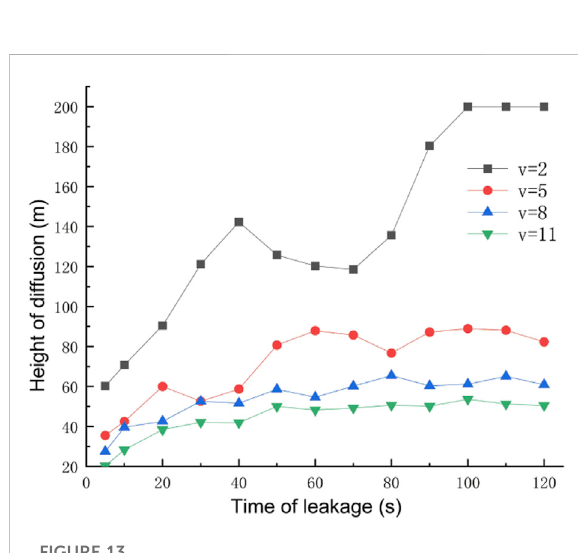
FIGURE 12 Concentration diagram of monitoring points under different ambient wind speeds after 120 s.